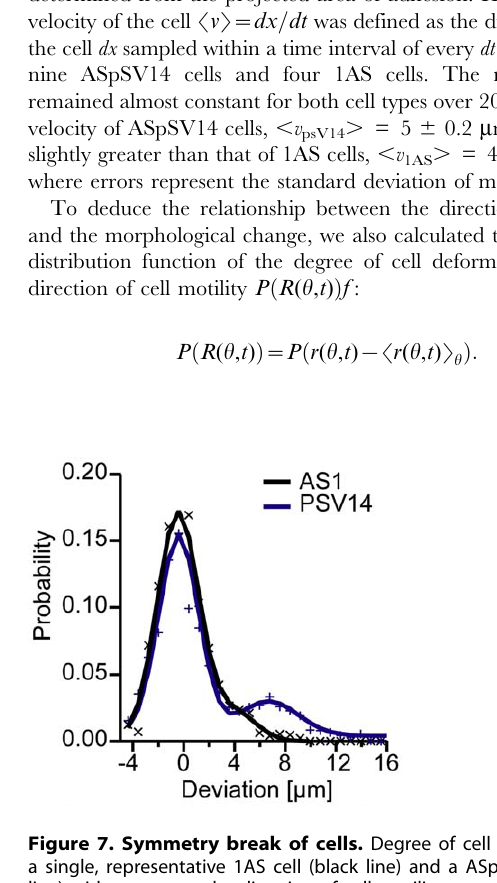
Figure 6. Cell shape fluctuation amplitude and autocorrelation map at late stage. (A) Amplitude R ( h , t ) map of representative 1AS and (B) ASpSV14 cells plotted as function of h recorded after the establishment of stable adhesion ( t = 600–1000 min). The corresponding autocorrelation of 1AS and ASpSV14 cells are presented in panel (C) and (D), respectively. Three RICM raw images are shown for (E) 1AS and (F) ASpSV14 cells at different time points. Scale bars: 10 m m.